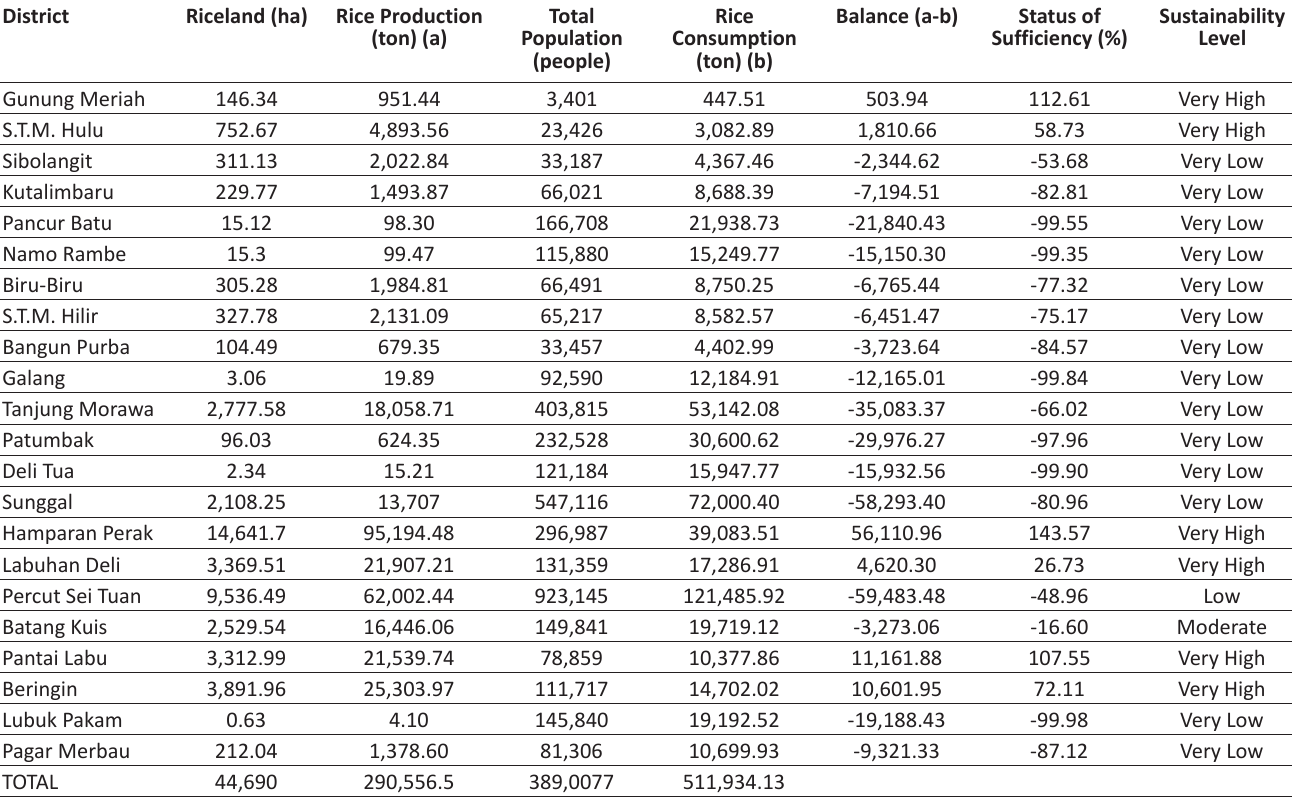
Table 7 . Rice production sustainability of Deli Serdang Regency by 2040 based on CO